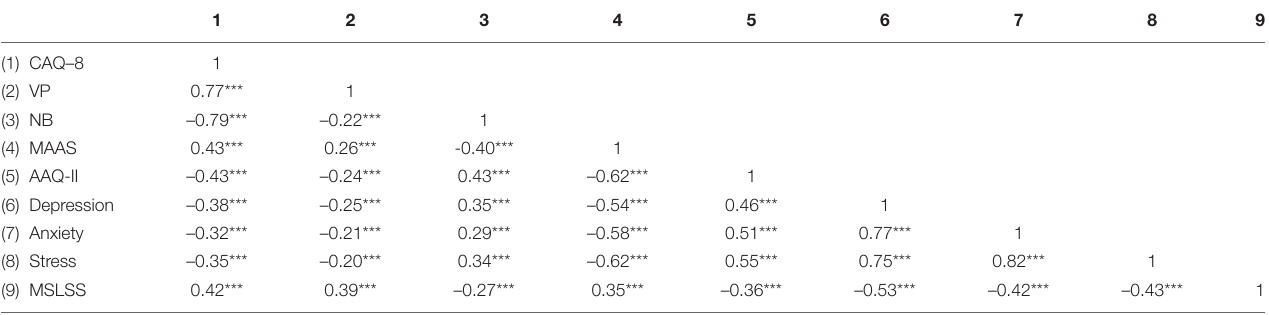
TABLE 4 | Correlations between CAQ-8 and relevant variables.